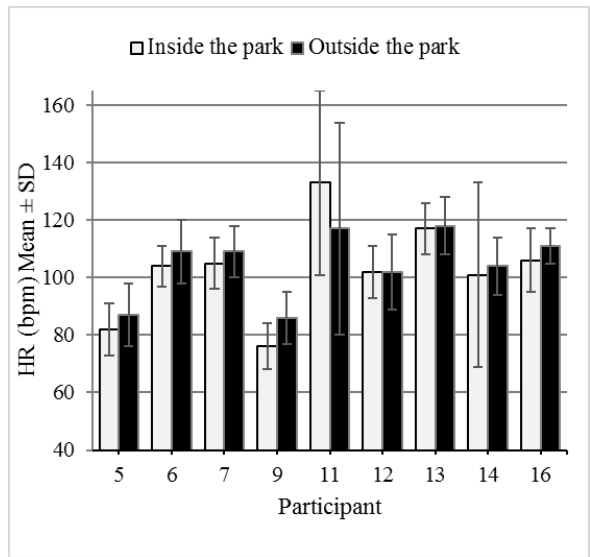
Figure 4. Means and SD of HR inside and outside the park area The visualization heat map of HR values (see figure 5) illustrates that participants have higher physiological arousal outside of the park area. This can be interpreted as a generally lower stress level among participants while inside the park.